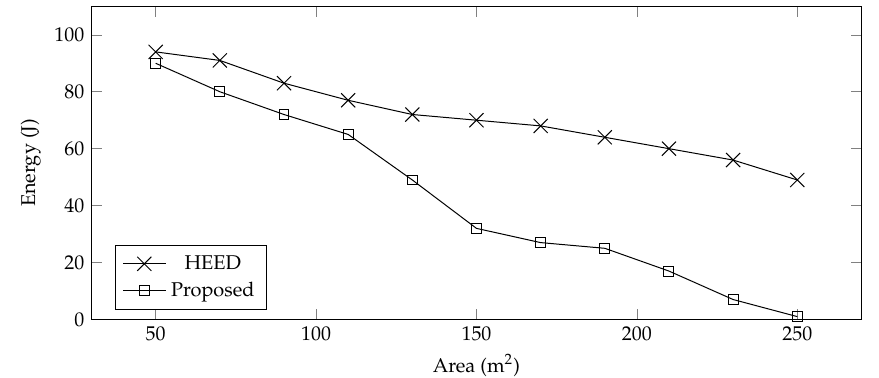
Figure 4. Energy consumption vs. farming area.